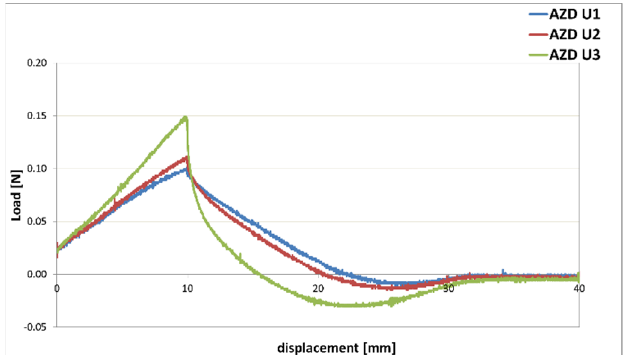
Figure 16. Texture curves obtained from an immersion/de-immersion test for the emulsions prepared with A-Z associations (ratio 1:1) at a total solid amount of 10% w/w, D at 0.1% w/w, and increasing amounts of a mixture of filters U (AZD U1 with 9% w/w of U; AZD U2 with 15% w/w of U; AZD U3 with 23.5% w/w of U).